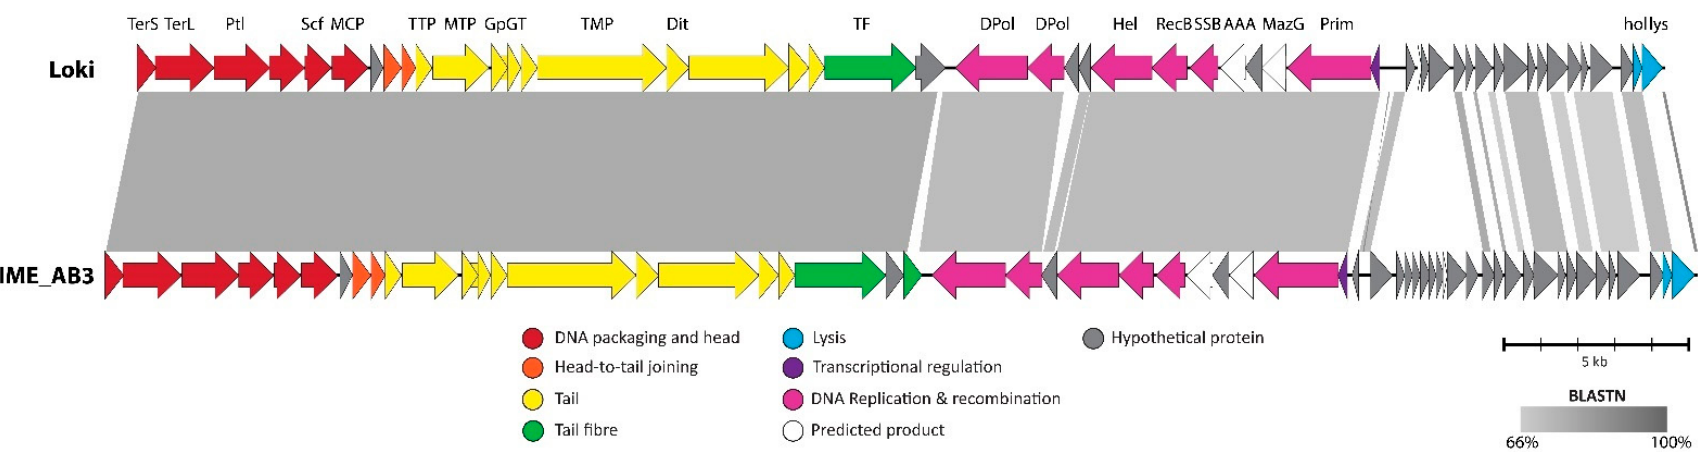
Figure 8. Pairwise BLASTn comparison of the Acinetobacter phages Loki and IME_AB3. The pairwise comparison clearly shows that these two phages are primarily distinguished by the constituent genes in the genomic module encoding the lysis cassette. Genes identified by bioinformatics analysis as belonging to specific modules are colour coded according to the key. Selected genes are annotated in the figure: TerS, small terminase subunit; TerL, large subunit terminase; Ptl, portal vertex protein; MCP, major capsid protein; MTP, major tail protein; GpGT, tail assembly chaperones GpG and GpGT; TMP, tape measure protein; Dit, distal tail protein; TF, tail fiber; DPol, DNA polymerase; Hel, helicase; recB, putative RecB-like recombination protein; SSB, single-stranded DNA-binding protein; AAA, AAA ATPase domain protein; hol, holin; lys, lysin. The figure was constructed using EasyFig and edited using Adobe Illustrator.